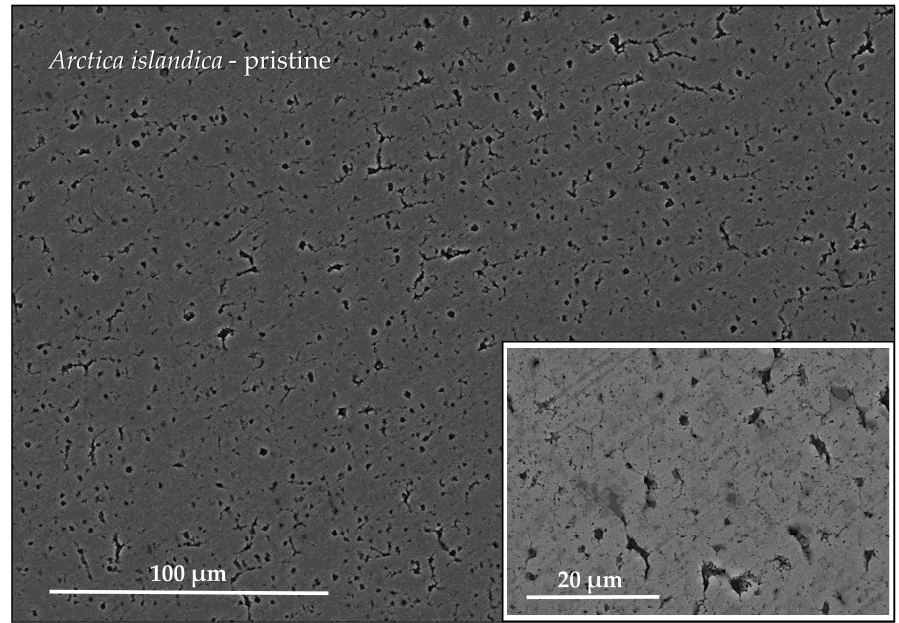
Figure A8. FE-SEM images of the portion of Arctica islandica shell that is next to seawater. This part of the shell is characterized by high porosity and larger sized mineral units compared to inner shell portions next to the soft tissue of the animal.